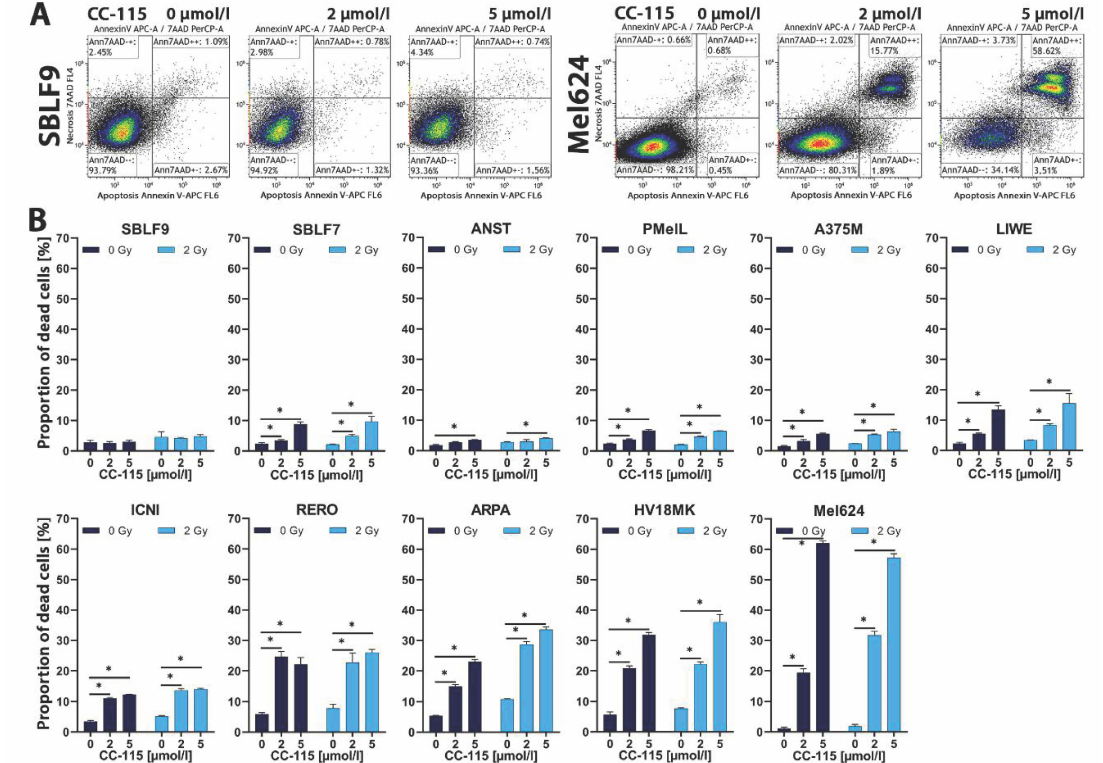
Figure 2. Cell death induced by CC-115 treatment with / without IR. ( A ) Flow cytometry was used for apoptosis / necrosis analysis by V-APC / 7-AAD staining. Unstained cells (Annexin-negative / 7-AAD-negative) were defined as viable cells. Annexin-positive / 7-AAD-negative cells were defined as apoptotic and Annexin-positive / 7-AAD-positive cells as necrotic. Examples for gating at different CC-115 concentrations (0, 2 and 5 µ mol / L) are shown, left: healthy-donor skin fibroblasts: SBLF9, right: melanoma cells: Mel624. ( B ) Graphs show proportion of dead cells (defined as sum of apoptotic and necrotic cells) at different CC-115 concentrations (0, 2 and 5 µ mol / L) with / without IR (2 Gy) in skin fibroblast (SBLF9, SBLF7) and melanoma cells (RERO, ANST, A375M, LIWE, ICNI, PMelL, ARPA, HV18MK, Mel624). Each value represents mean